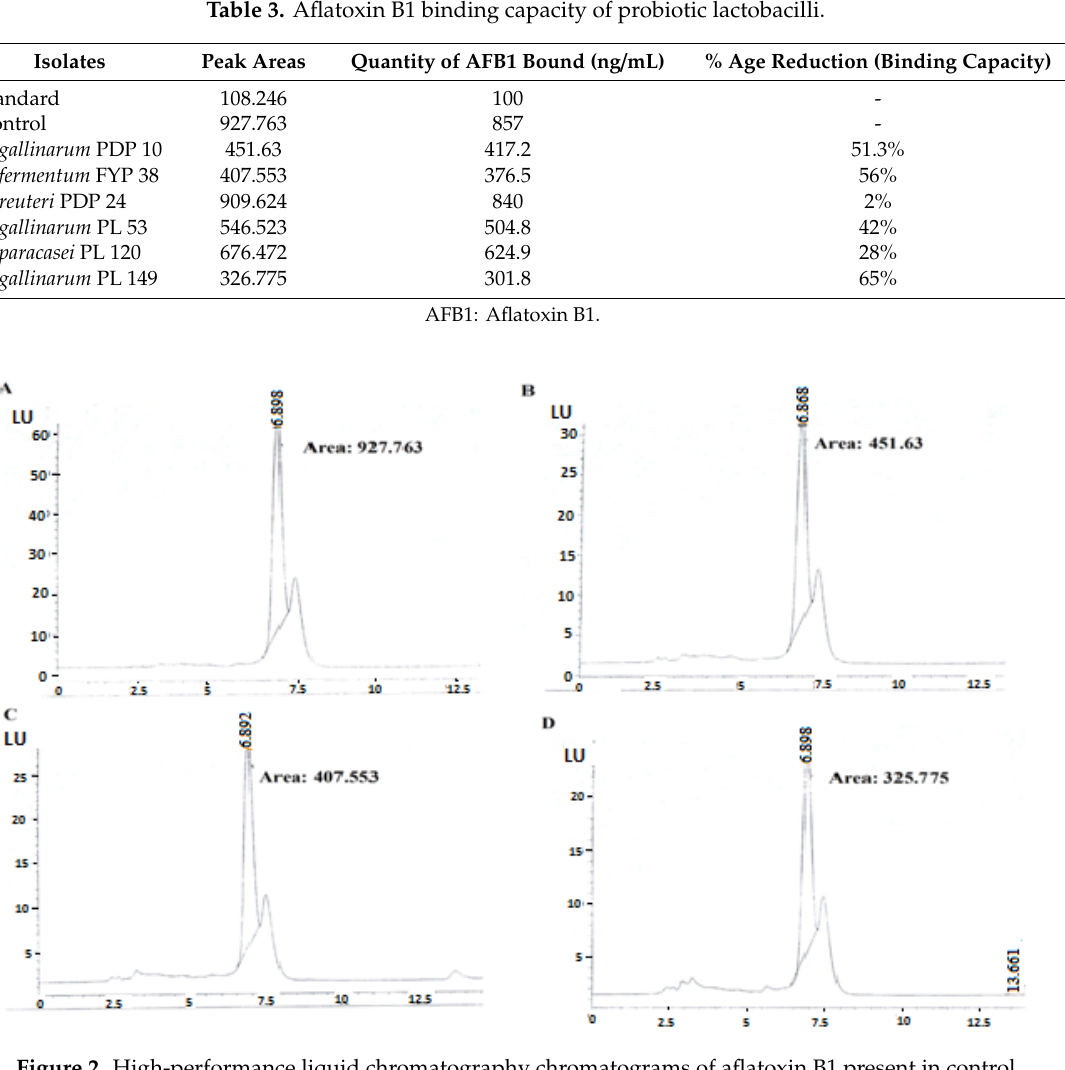
Figure 2. High-performance liquid chromatography chromatograms of aflatoxin B1 present in control and suspension after treatment with lactobacilli: ( a ) Control; ( b ) PDP 10; ( c ) FYP 38; ( d ) PL